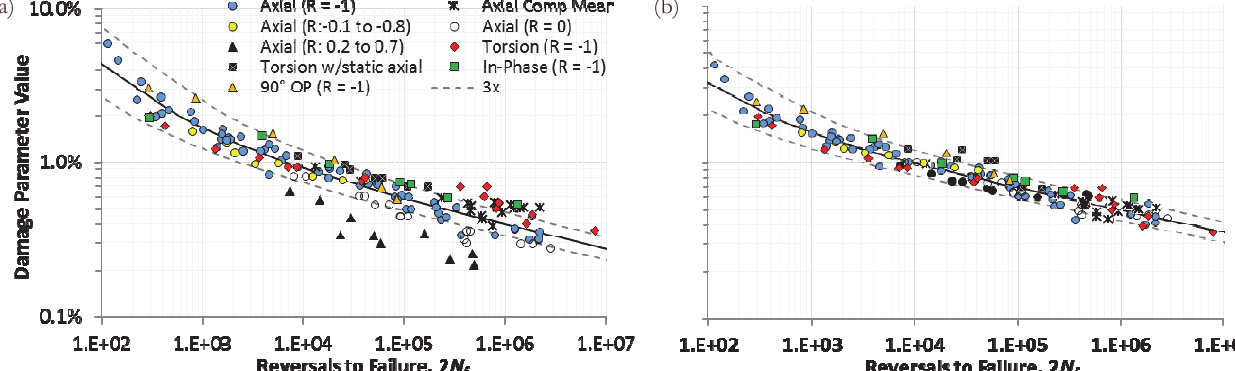
Figure 1: Fatigue life correlations for 7075-T651 aluminum alloy based on (a) FS and (b) modified FS parameters with uniaxial strain- life properties and k =